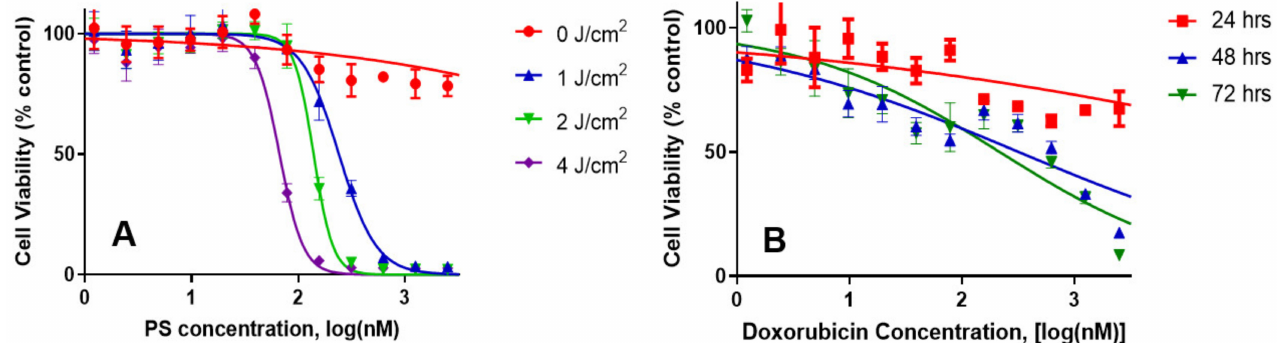
Figure 3. A co-culture system containing PDX 14541 tumor cells and normal lung-fibroblast cells transfected with GFP. PS 1 uptake (red) was observed in both Tween ® -80 and Pluronic ® F-127 formulations within the tumor cells. GFP-transfected fibroblast cells are shown in green. While both tumor cells and fibroblast demonstrated PS fluorescence, the PS concentration amount (fluorescence intensity) observed in normal fibroblast cells was significantly lower than in tumor cells. Compared to Tween 80 formulation, the PS 1 in Pluronic F-127 formulation showed more evenly PS distribution. Hoechst 33342 was used to stain the nucleus of the cells (blue). The PS 1 did not show any localization in cell nucleus. The fluorescence intensity of the PS 1 in Tween and Pluronic formulations was measured by ImageJ software (see scale bars).